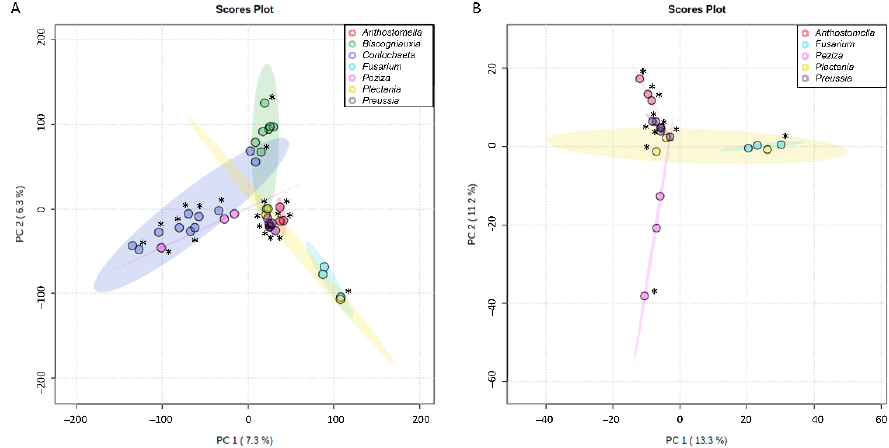
Figure 2. Principal component analysis score plots for the 38 endolichenic fungal extracts investigated based on HPLC-MS/MS data figuring the 2 first principal components for the totality of the extracts ( A ) or after removal of signals from Coniochaeta and Biscognauxia extracts ( B ). Colors were attributed to the different fungal genus investigated in the present study ( Anthostomella (red), Bis- cogniauxia (green), Coniochaeta (blue), Fusarium (cyan), Peziza (pink), Plectania (yellow), Preussia (pur- ple)). Active extracts (*) inducing more than 50% adherence inhibition at 50, 100 or 200 µg/mL in 48 h are highlighted. They correspond to AP_SAB ( Anthostomella pinea ), AP_PDA ( A. pinea ), AP_MEA ( A. pinea ), CL_SAB ( C. lignicola ), CL_PDA ( C. lignicola ), CL_MEA ( C. lignicola ), PP_1_PDA ( P. per- sica ), PP_1_SAB ( P. persica ), PV_MEA ( P. varia ), PSP_MEA ( Plectania sp.), CD_MEA, ( Coniochaeta decumbens ), CH_PDA ( Coniochaeta hoffmannii ), CH_MEA ( C. hoffmannii ), CH_SAB ( C. hoffmanii ), PP_2_MEA ( Preussia persica ), PP_2_PDA ( P. persica ), PP_2_SAB ( P. persica ), FA_PDA ( Fusarium av- enaceum ), BM_1_PDA ( Biscogniauxia mediterranea ), BM_1_SAB ( Biscogniauxia mediterranea ). According to this first insight into endolichenic fungal metabolomes, it was decided to treat the data from samples by genus for further investigation. 3.4. Research for Active Compounds by Biochemometrics and Molecular Networking To highlight the compounds related to the activity observed, the recently described FiBiCo script was applied to the different features recovered from peak picking analysis [19]. In fact, peak areas for each feature were compared together and analyzed in correla- tion with the anti-maturation activity observed in the different extracts. Each feature then